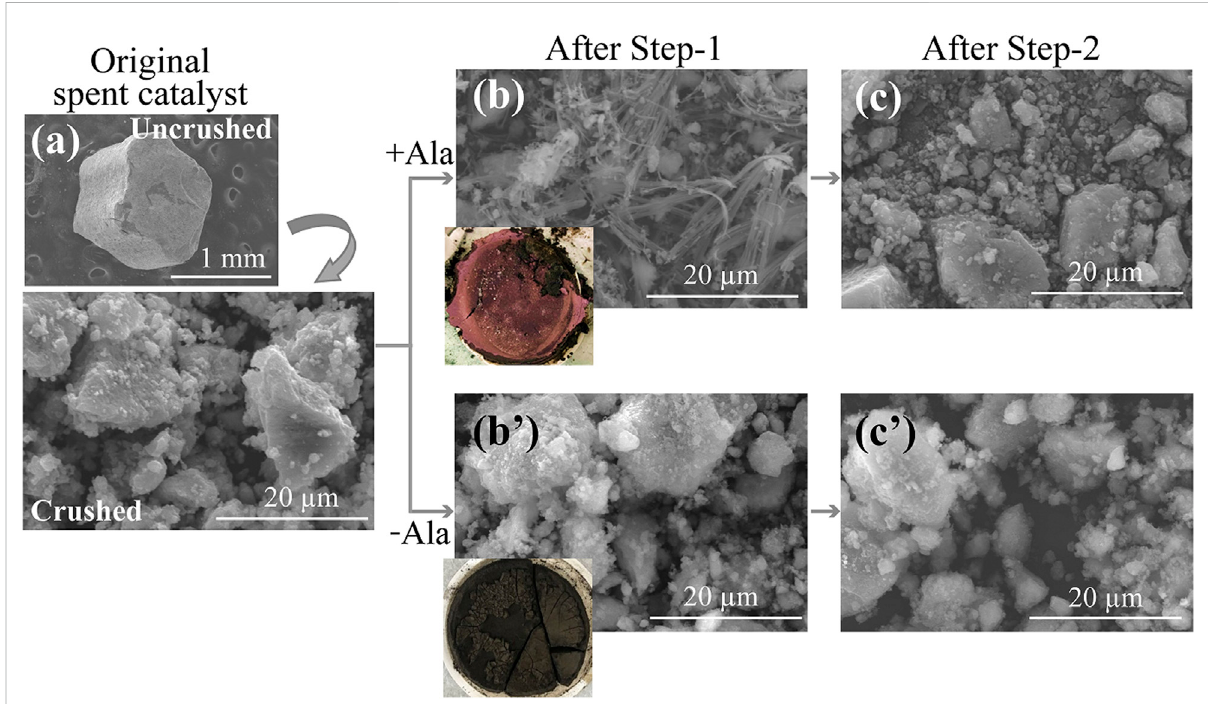
FIGURE 4 SEMimagesshowingmorphologicaland colorimetric differences ofCo-precipitatesformedduringtheStep-1 and theirtransitionduringStep- 2. (A) Original spent catalyst (before and after crushing). (B,B 9 ) The leaching residue after Step-1 (B) ; Ala system, (B 9 ) ; Ala-free control. (C,C 9 ) The leaching residue after Step-2 (C) ; Ala system applied in Step-1, (C 9 ) ; Ala-free control system applied in